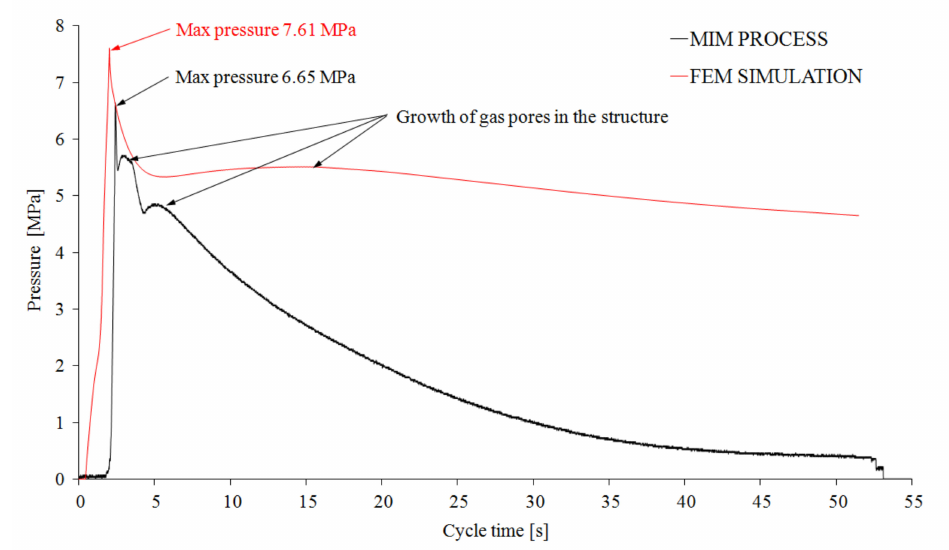
Figure 22. Pressure changes in the molding cavity for real (MIM) and simulated (FEM) processes, black and red curves,